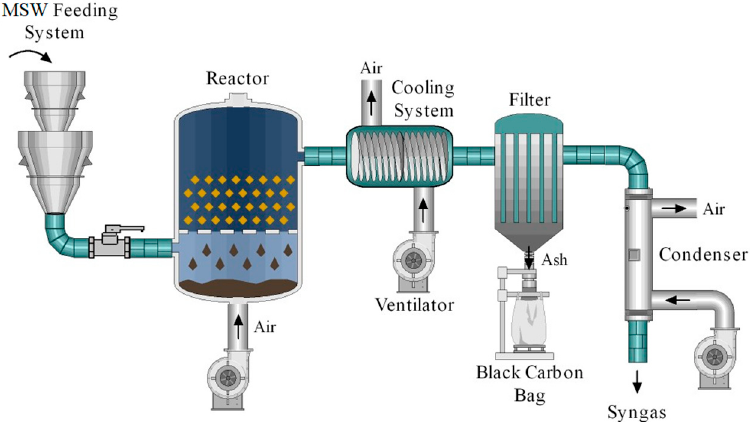
Figure 4. Schematics concerning the main components of the pilot scale gasification plant at the Polytechnic Institute of Portalegre, Portugal.